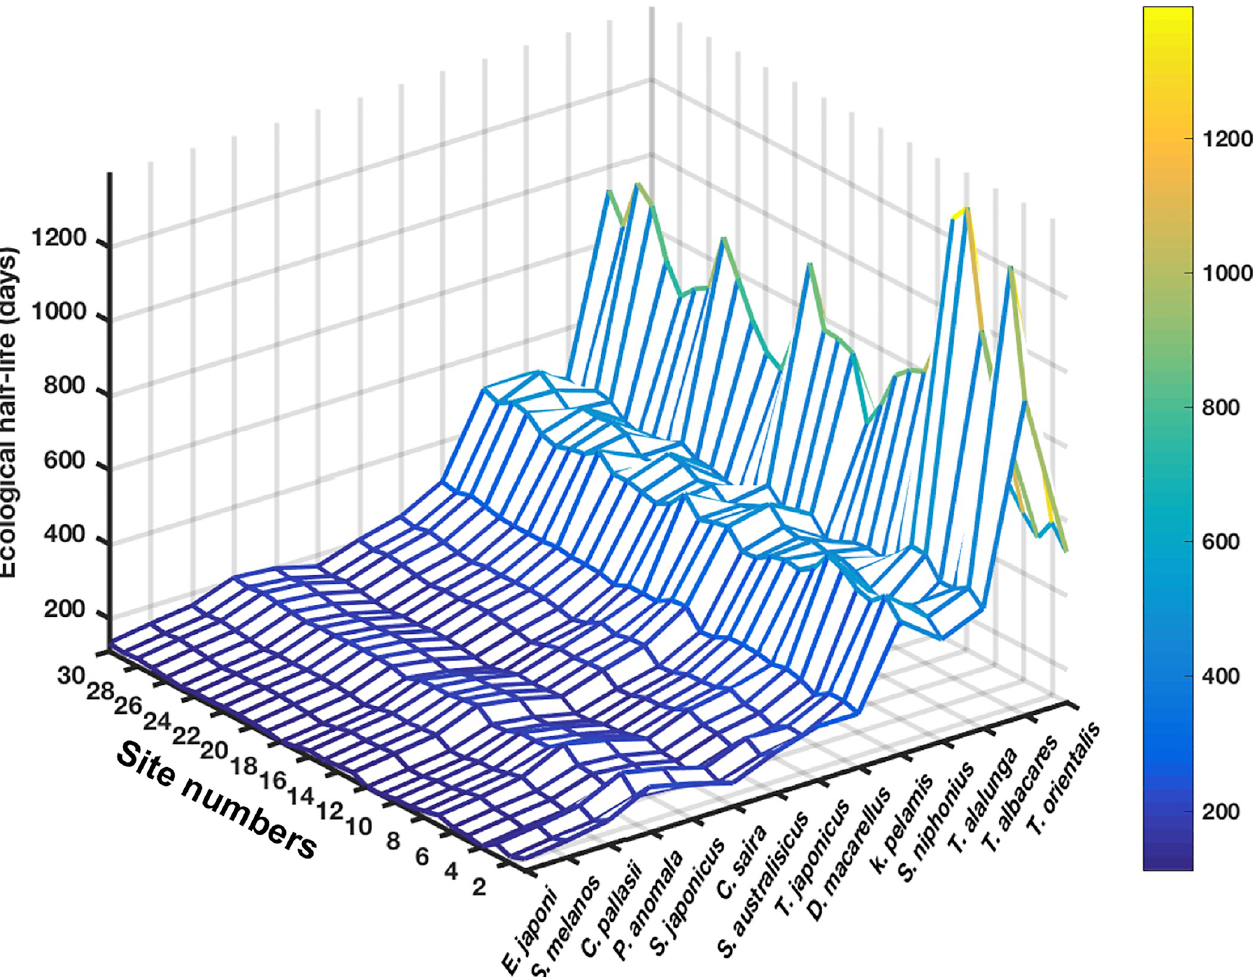
Fig 14. Estimated ecological half-lives (in days) shown as function of studied species (x-axis) and sites (y-axis). The studied species are shown in an increasing order of their asymptotic Lengths.